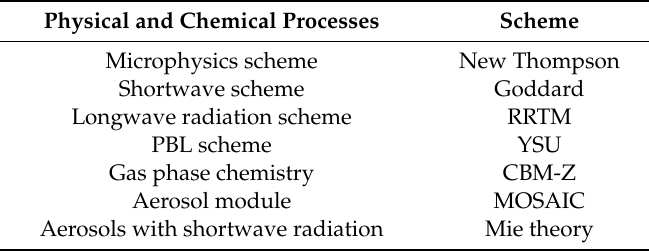
Table 1. Physical and chemical options included in the